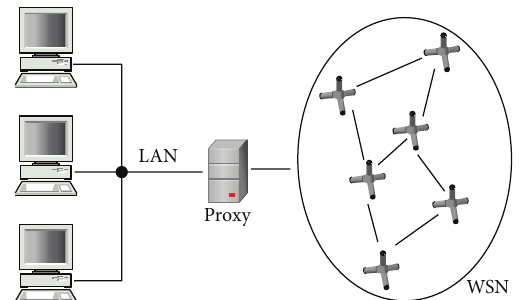
Figure 1: Interconnection of a WSN with remote human interfaces via